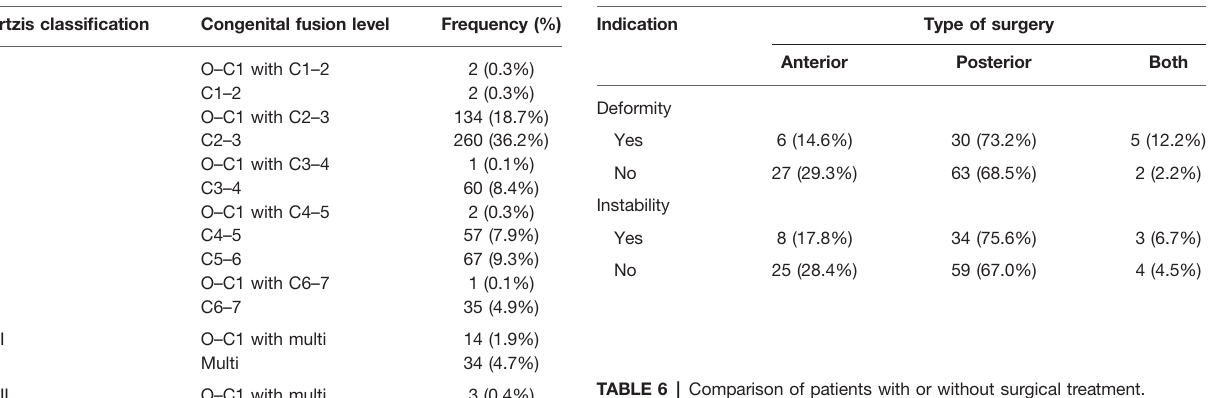
TABLE 1 | Distribution of congenital fusion levels.